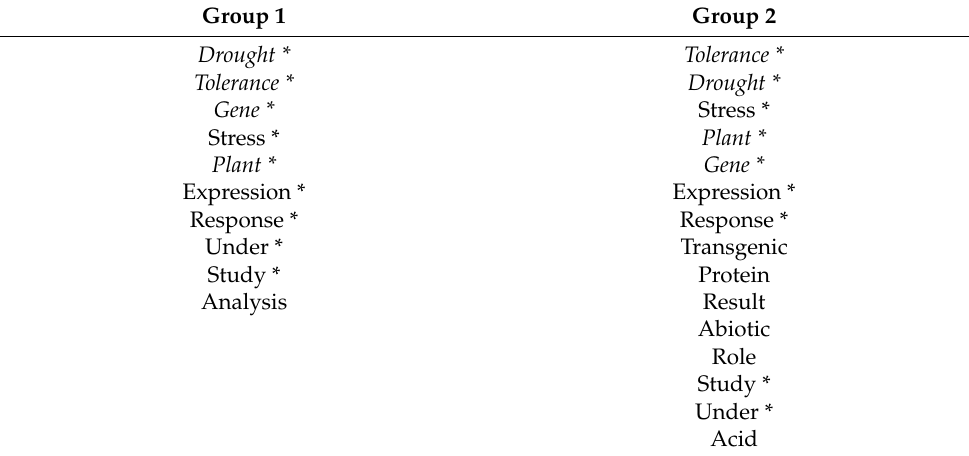
Table 1. A comparison of the words shared by over 50% of the abstracts in each group our module 1 analysis found. Words in italic are the search terms. Words with a star (*) next to them are shared between both groups. Group 1 Group 2 Drought * Tolerance * Tolerance * Drought * Gene * Stress * Stress * Plant * Plant * Gene * Expression